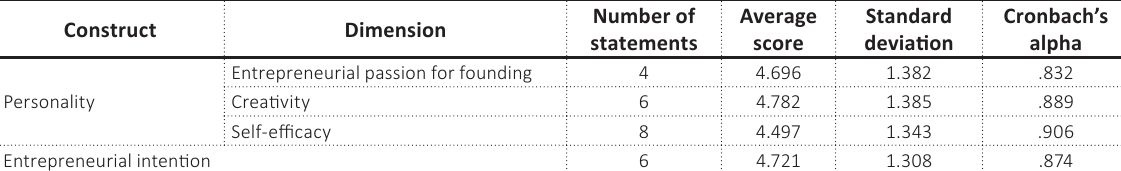
Table 1. Descriptive and reliability